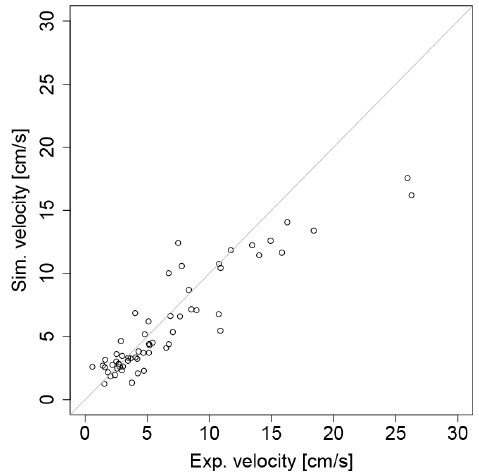
Figure 13. Comparison of simulated (line) and experimental (cir- cles) steady velocities in the Thiès field